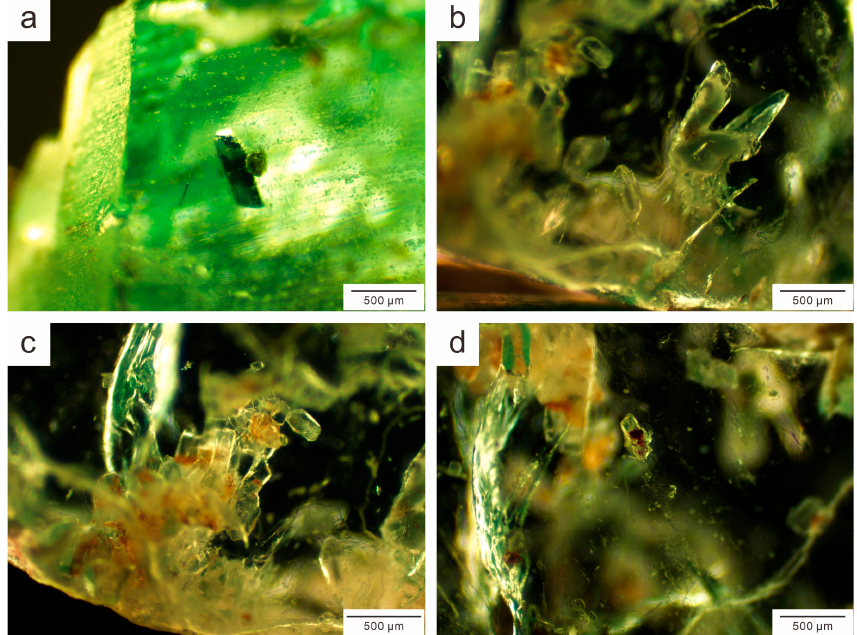
Figure 5. ( a ) Black prism tremolite in emerald (KAM-15); ( b ) Fluorapatite inclusions with colorless, transparent rim and a greyish, hazy interior in emerald (KAM-8); ( c ) Colorless transparent fluorapatite cluster in emerald (KAM-8); ( d ) Colorless plate crystals infiltrated with red Fe oxide impurities in emerald (KAM-8).